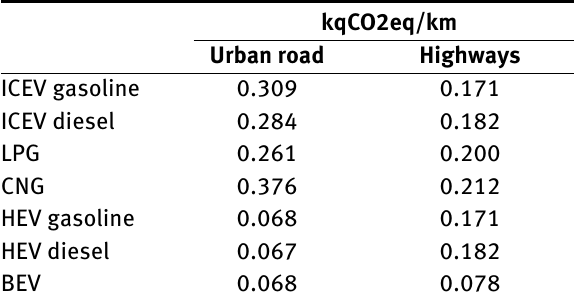
Table 1: Emissions factors per unit distance travelled